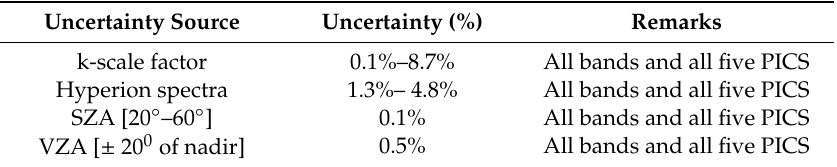
Table 15. Absolute calibration model parameter uncertainties.